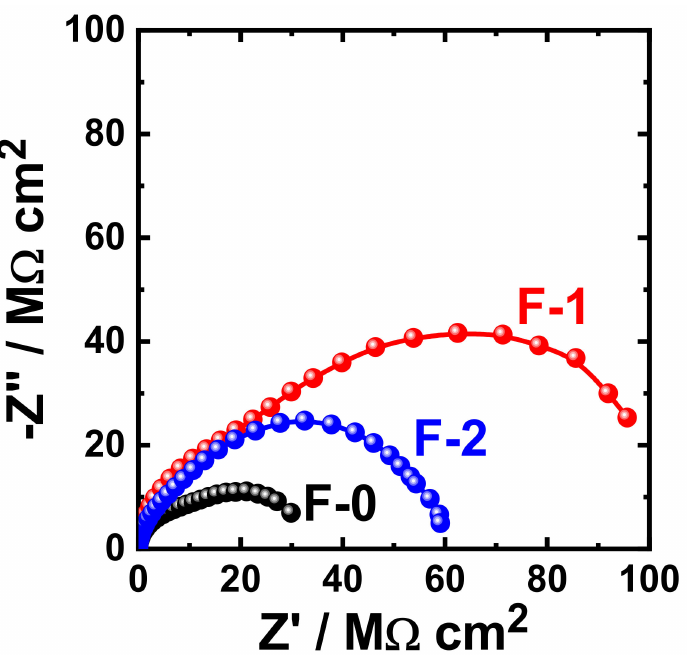
Figure 15. Typical Nyquist plots obtained for F-0, F-1, and F-2 after their immersion in 3.5% NaCl solutions for 1